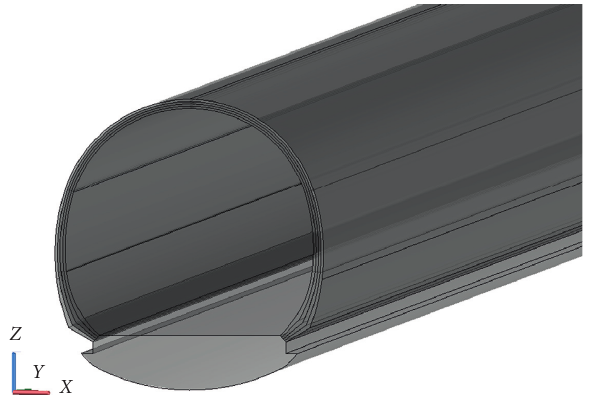
Figure 12: Model of inner lining.